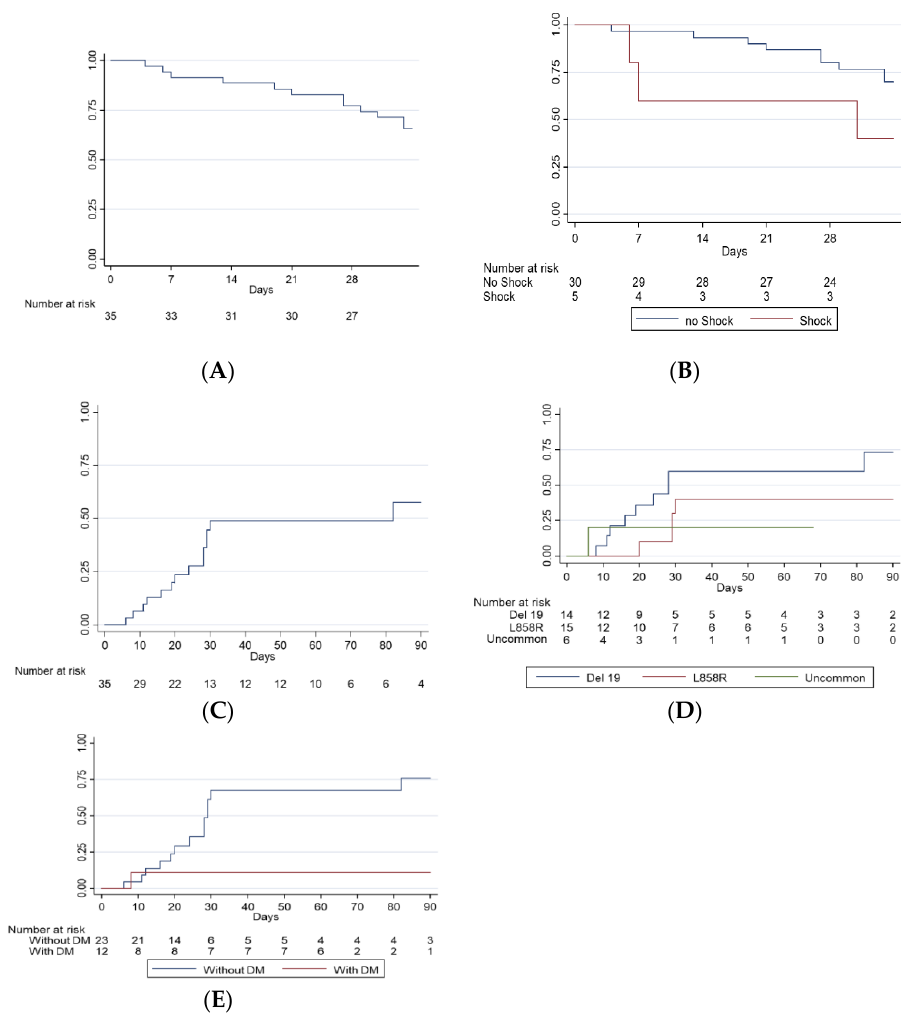
Figure 2. Survival and rate of successful weaning from mechanical ventilation of lung cancer patients receiving EGFR-TKIs in the ICU. ( A ) 28-day ICU survival. ( B ) Kaplan–Meier plot of survival in group with shock or not. ( C ) Cumulative incidence of patients with successful weaning from mechanical ventilators. ( D ) Cumulative incidence of successful weaning in patients with different EGFR mutation. ( E ) Cumulative incidence of successful weaning in patients with or without DM. Acronyms: EGFR = epidermal growth factor receptor, ICU = intensive care unit, TKI = tyrosine kinase inhibitor, DM = diabetes Table 2. Univariate and multivariate analysis of clinical factors associated with 28-day ICU survival.